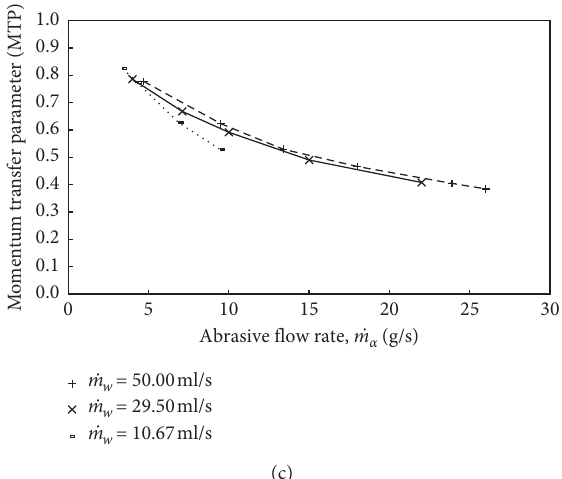
Figure 12: Momentum transfer parameter with different focus geometry parameters: (a) effects of focus diameter at l effects of focus length at d f � 1 . 02 mm; (c) water flow rate at d f � 1 . 02 mm and l f � 76 . 2